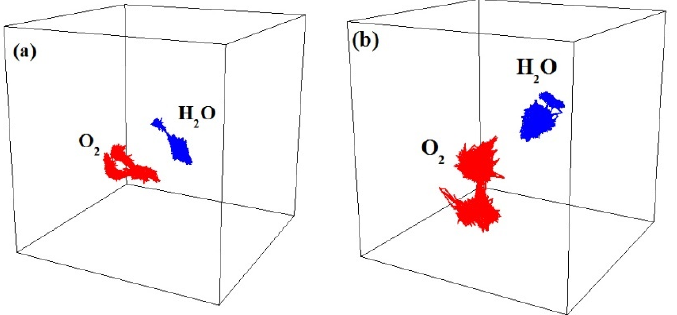
Figure 10. The representative trajectories of O 2 and H 2 O in ( a ) 2,7-CPPI and ( b ) M-2,7-CPPI. The MSD vs. time plots of H 2 O and O 2 in the two polyimides are presented in Figure 11. According to Einstein’s equation, the diffusion coefficients (D) of O 2 and H 2 O were